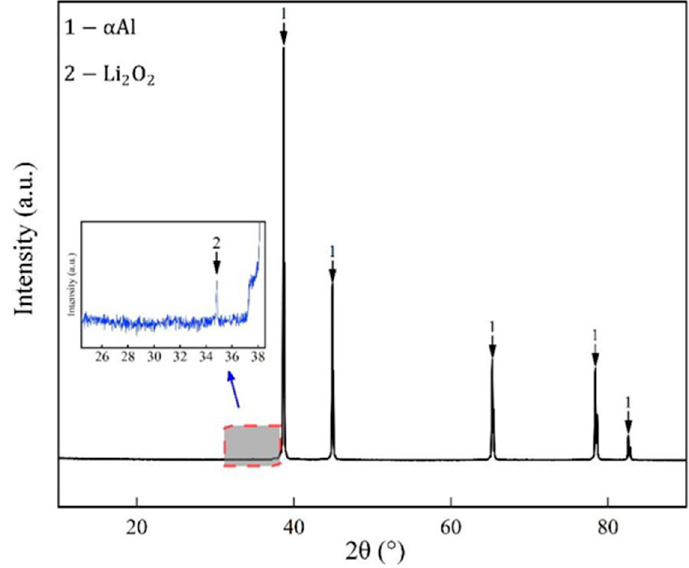
Figure 3. The XRD pattern of Al-Li alloy microparticles.